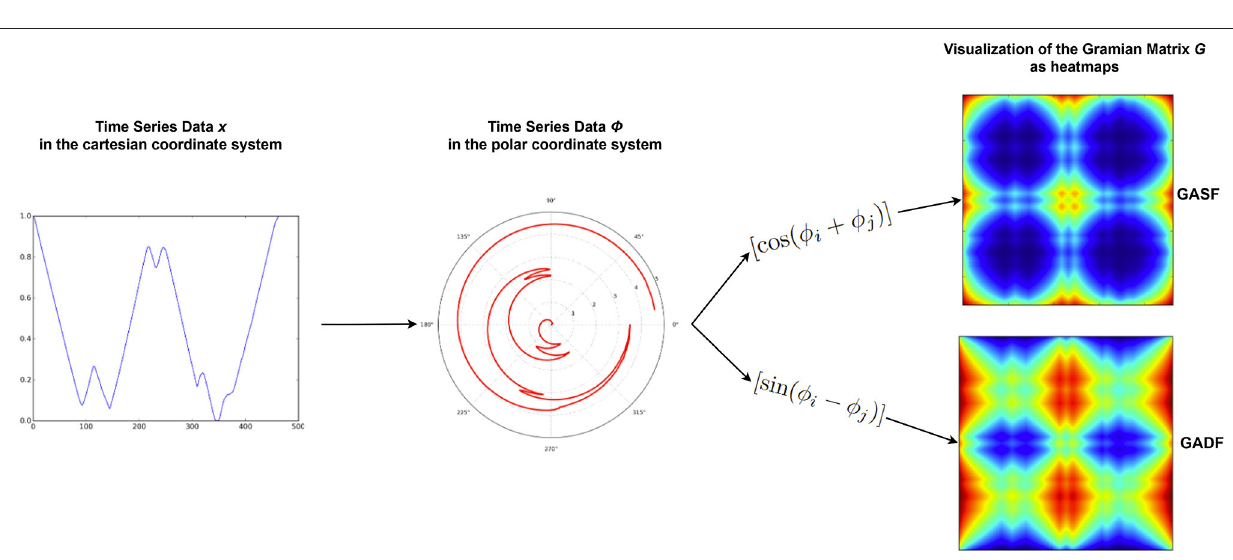
(Keogh and Pazzani, 2000). The effect of blurring will be discussed in section